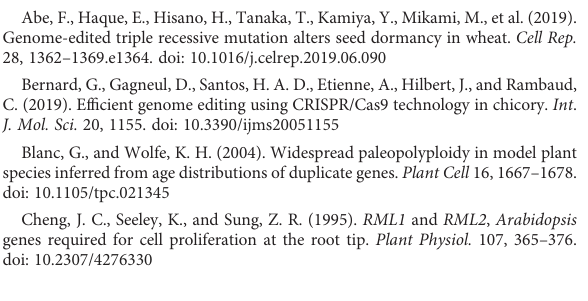
FIGURE S5 Mutation at Rj7 target site mediated by p AtGCSpro 1178 -Cas9 and p AtGCSpro 833 -Cas9 system in soybean, respectively, by PCR-RE assays and Sanger sequencing analysis. PCR-RE assays mutation ef fi ciency in the Rj7 target loci from different independent p AtGCSpro 1178 -Cas9 and p AtGCSpro 833 -Cas9 hairy roots, respectively (A, B) . Lanes WT and WTE, undigested PCR ampli fi cation fragment and digested wild-type controls by Eco RI, respectively. Lanes 1-30, different independent transgenic hairy roots (A) . Lane 1, 3-11, 13, 17-18, 20, 22-23, 25-28, and 30 were homozygous/ biallelic mutations (A) . Lanes 1-20, different independent transgenic hairy roots (B) . Lane 1, 3, 5-7, 12, 14, and 17-19 were homozygous/ biallelic mutations (B) . An example of sequencing analysis on the mutation at Rj7 target site was given in p AtGCSpro 1178 -Cas9 and p AtGCSpro 833-Cas9 system, respectively. Black arrows indicate the site of indels mutation. The PAM region and mutated target site are shown in the box (C) . FIGURE S6 Mutation at GmNNL1Rfg1 target sites in soybean mediated by p 2×35Spro -Cas9 and p AtGCSpro 1178 -Cas9 system, respectively, and PCR-RE assays and Sanger sequencing analysis. Sequence of an sgRNA designed to target a site within the fi fth exon region of GmNNL1 (A) and Rfg1 (B) , respectively. The Hin dIII (A) and Nco I (B) restriction site is underlined, respectively. The PAM sequence is highlighted in blue. PCR-RE analysis the targeted mutation at GmNNL1 site using Hind III restriction enzyme digestion. In the hairy roots transformed with the p 2×35Spro -Cas9- GmNNL1Rfg1 vector, no homozygous or biallelic mutations lines were obtained among 30 independent transgenic lines (C) . PCR-RE analysis the targeted mutation at Rfg1 site using Nco I restriction digestion. In the hairy roots transformed with the p 2×35Spro -Cas9- GmNNL1Rfg1 vector, 41 10 lines (#5-7, #11, #14-17, #19, and #26) were homozygous or biallelic mutations among 30 independent transgenic lines (D) . PCR-RE analysis the targeted mutation in GmNNL1 site in the hairy roots transformed with the p AtGCSpro 1178 -Cas9- GmNNL1Rfg1 vector using Hind III restriction enzyme digestion. 2 lines (#28, and #30) were homozygous or biallelic mutations among independent transgenic lines (E) . PCR-RE analysis the targeted mutation at Rfg1 site in the hairy roots transformed with the p AtGCSpro 1178 -Cas9- GmNNL1Rfg1 vector using Nco I restriction enzyme digestion. 25 lines (#1-4, #7-11, #13-15, #17-28, and #30 ) were homozygous or biallelic mutations among 30 independent transgenic lines (F) . An example of sequencing analysis on the mutation at GmNNL1 target site was given in p AtGCSpro 1178 -Cas9- GmNNL1Rfg1 and p 2×35Spro -Cas9- GmNNL1Rfg1 system, respectively. WT represents wild type. Black arrows indicate the site of indels mutation (G) . An example of sequencing analysis on the mutation at Rfg1 target site was given in p AtGCSpro 1178 -Cas9- GmNNL1Rfg1 and p 2×35Spro -Cas9- GmNNL1Rfg1 system, respectively. Black arrows indicate the site of indels mutation (H) .